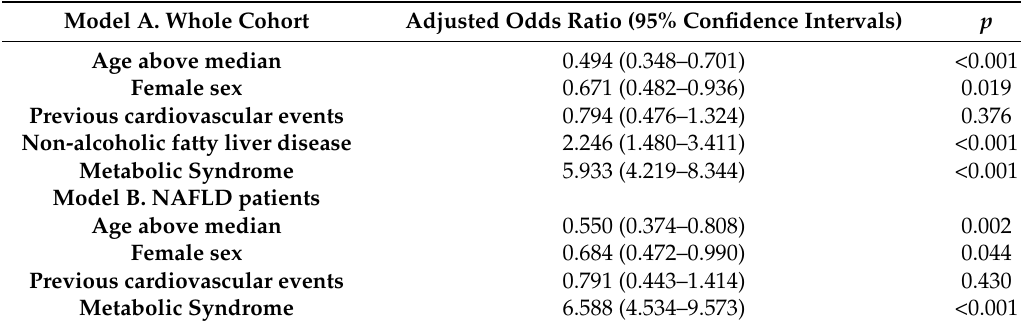
Table 2. Multivariable logistic regression analysis of factors associated with fasting remnant lipoprotein cholesterol (above median) in the whole population (Model A) and in patients with non-alcoholic fatty liver disease (NAFLD) (Model